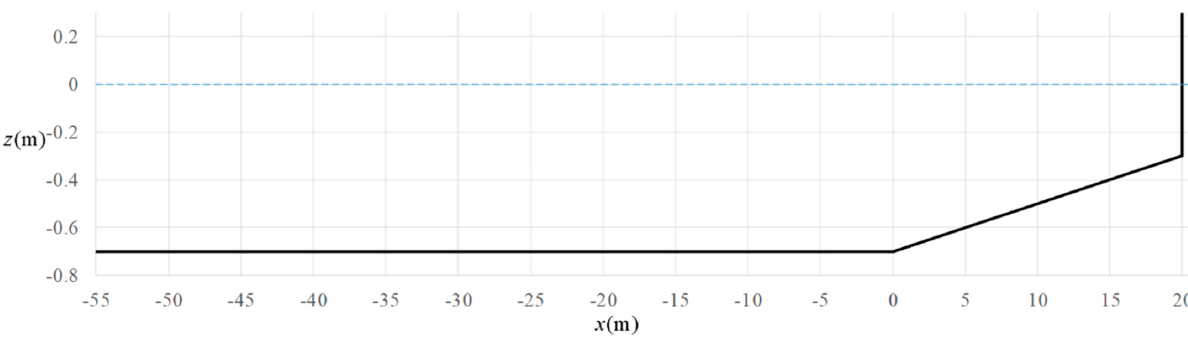
Figure 3. Snapshots of the free surface profiles in the test case of solitary wave reflection after run- ning up a slope. Black solid lines are the free surface. The blue dash lines are the static water level. The height of each cell is 0.05 m.